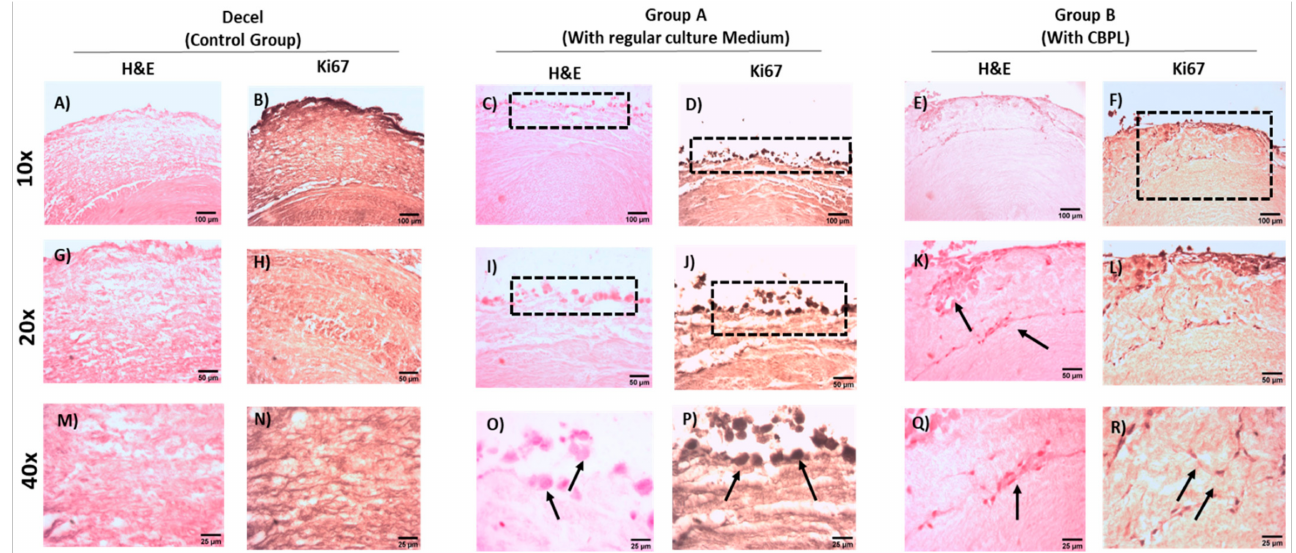
Figure 8. Histological analysis of repopulated vascular grafts with WJ-MSCs P3, located in the tunica adventitia. Decellu- larized hUAs stained with H&E ( A , G , M ). Repopulated hUAs of group A ( C , I , O ) and group B ( E , K , Q ) stained with H&E. Immunohistochemistry against Ki67 in decellularized hUAs ( B , H , N ), and repopulated hUAs of group A ( D , J , P ) and group B ( F , L , R ). Images ( A – F ) presented with original magnification 10 × , scale bars 100 µ m. Images ( G – L ) presented with original